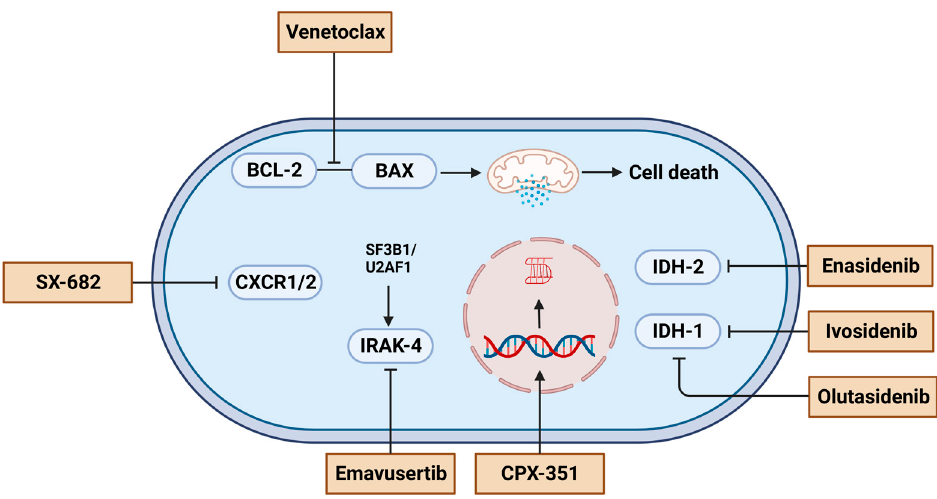
Figure 2. A summary of experimental agents and their cellular targets for treating myelodysplastic syndrome or acute myeloid leukemia after hypomethylating agents failure. Figures were generated with